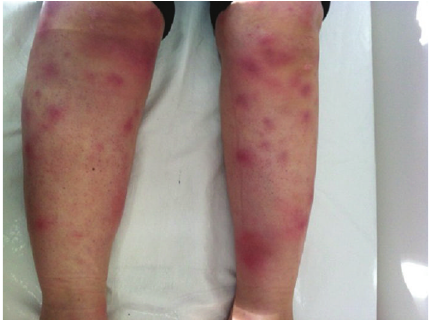
Figure 1: Erythema nodosum lesions on the bilateral pretibial regions.